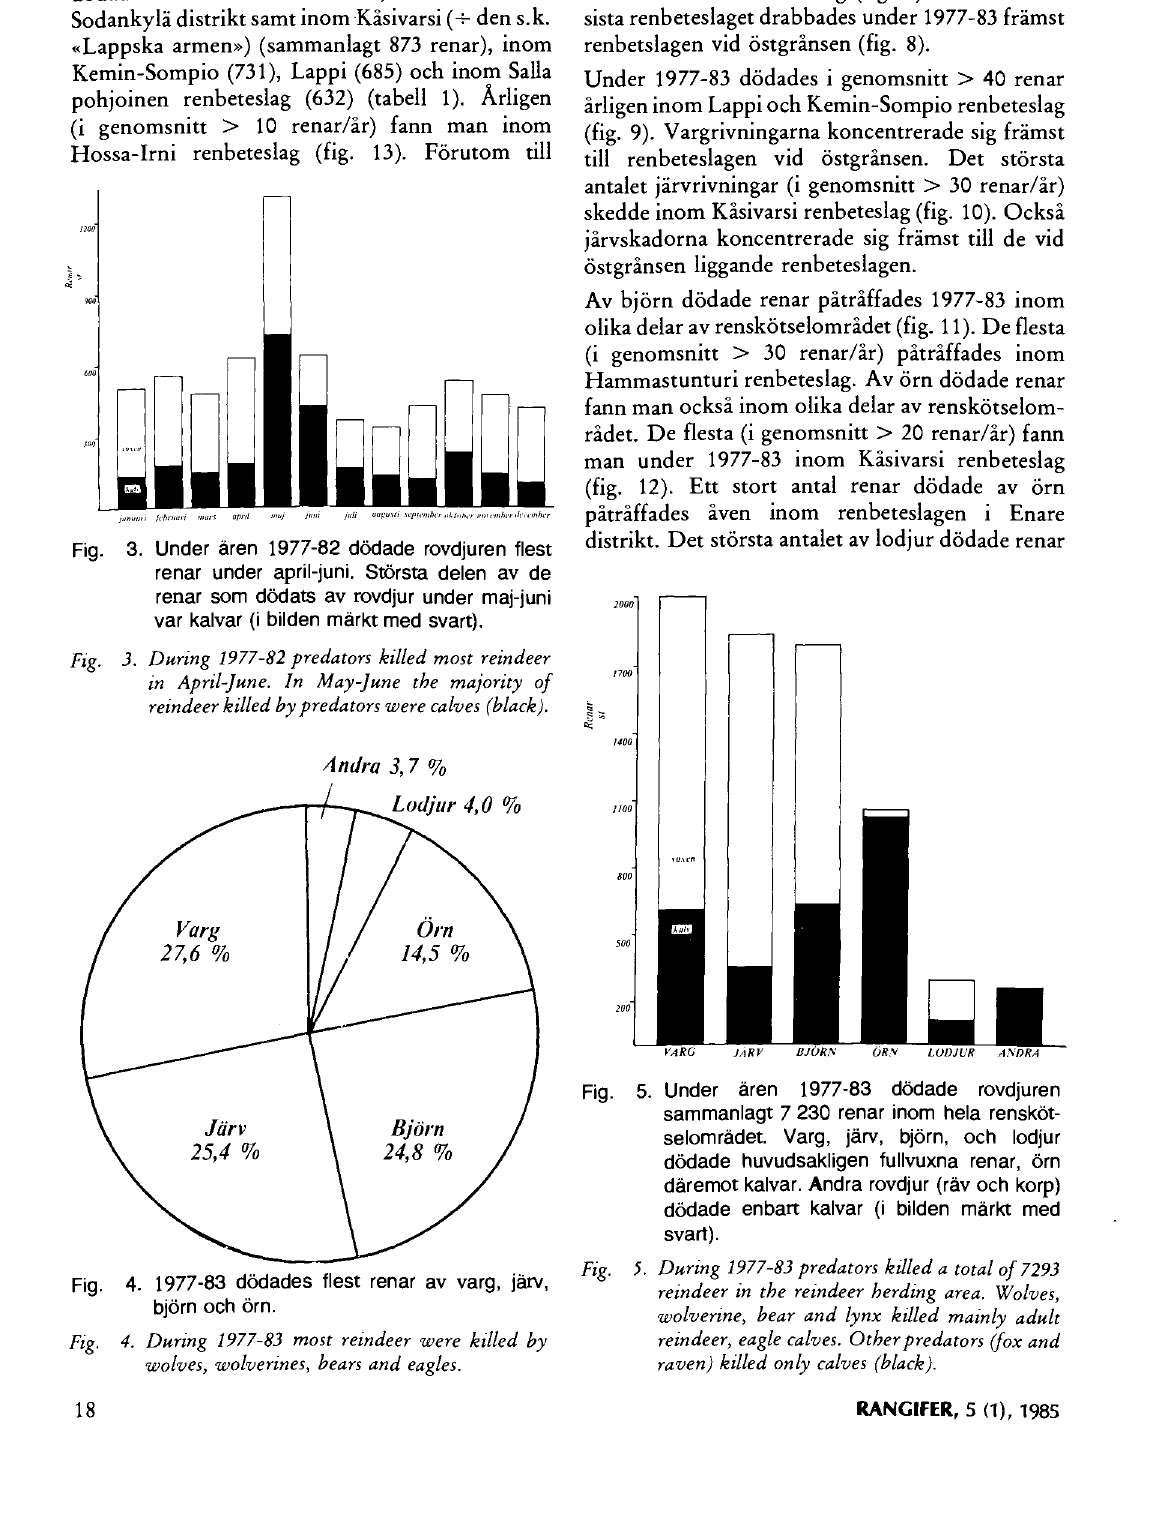
4. 1977-83 dodades flest renar av varg, jarv, bjorn och orn. Fig. 4. During 1977-83 most reindeer were killed by wolves, wolverines, bears and eagles.